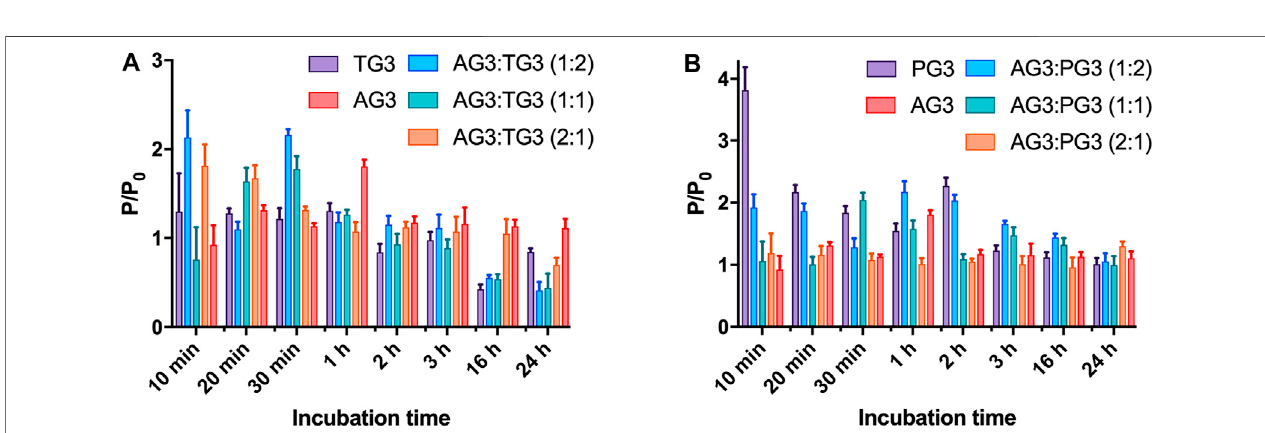
FIGURE4| Evolutionof fl uorescencepolarizationofsiRNAuponreleaseofdendriplexesfromtheagarosegel.DendriplexescontaineitherAG3andTG3 (A) orAG3 and PG3 (B) . The ratio P/P 0 represents the ratio of fl uorescence polarization values in a sample ( P ) and that of free siRNA ( P 0 ). Charge ratio 5.